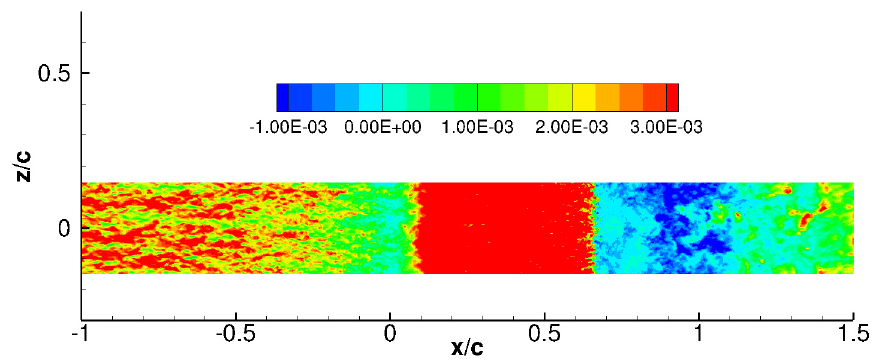
Figure 15. WA-WMLES of NASA hump flow: instantaneous skin friction coefficient on the streamwise-spanwise